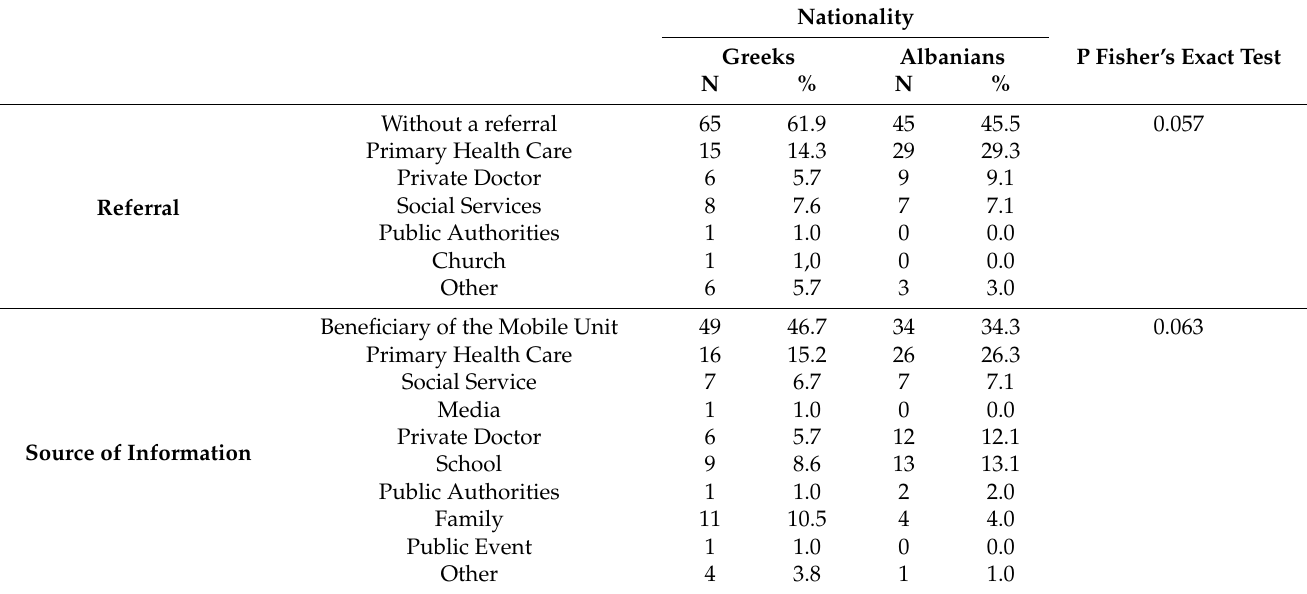
Table 3. Source of initial referral and information about the Unit.